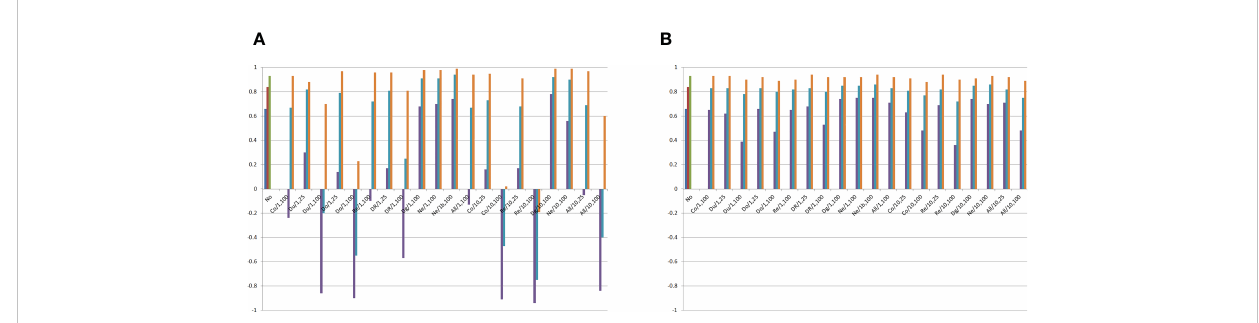
FIGURE 4 Minimum, average, and maximum correlations between the average frequency for the genes that increase the trait expression or the average allelic frequency differences between the DH lines and the genetic components of the combining ability analysis, assuming no epistasis (No), seven types of digenic epistasis and an admixture of these types (All), 25% and 100% of epistatic genes, ratio V(I)/(V(A) + V(D)) of 1 and 10, and 100 samples of 20 . Co = complementary, Du = duplicate, Do = dominant, Re = recessive, DR = dominant and recessive, Dg = duplicate genes DHs. (A) g * j and (B) s * jj 0 with cumulative effects, and Ne = non-epistatic genic interaction. b = no